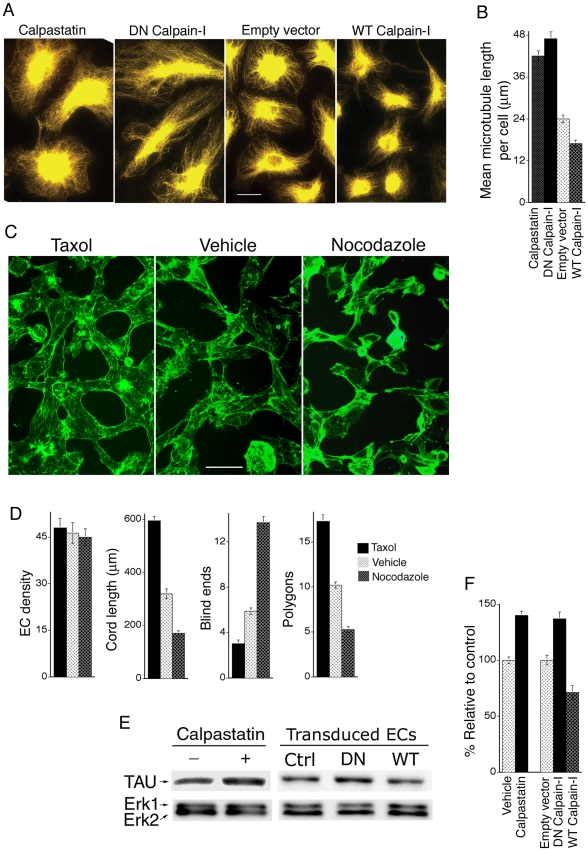
DN calpain-1 supports integration of vascular cord networks by enhancing the microtubule cytoskeleton.(A) MVECs transduced with DN calpain-I or calpastatin peptide (200 nM) exhibited a robust microtubule cytoskeleton relative to Empty Vector controls. In contrast, cells transduced with WT calpain-I exhibited a markedly diminished microtubule cytoskeleton. Microtubules were stained with α-tubulin antibody; bar  = 25 µm. (B) Quantification of mean microtubule lengths (n>20 cells; p<0.001 for DN calpain-I vs. empty vector; p<0.05 for WT calpain-I vs. empty vector; p<0.001 for calpastatin peptide vs. vehicle control). (C) Equal numbers of MVECs were stimulated with collagen-I to undergo capillary morphogenesis (as in Figure 2). Treatment with the microtubule-stabilizing agent taxol (15 µM) during the final hour of cord formation, i.e. three hours after the initiation of capillary morphogenesis (see Methods), improved cord formation and reduced blind ends whereas incubation with the microtubule-destabilizing agent nocodazole (15 µM) impaired cord formation and increased blind ends (white arrows). Cords were stained for F-actin with phalloidin; bar  = 50 µm. (D) Quantification of cord organization; n≥17; measured parameters correspond to actual areas of 0.4 mm2. Cord length: taxol vs. control p<0.001; nocodazole vs. control p<0.001. Blind ends: taxol vs. control p<0.002; nocodazole vs. control p<0.003. Polygons (closed vascular loops): taxol vs. control p<0.001; nocodazole vs. control p<0.001. (E) As determined with immunoblotting, the microtubule-stabilizing protein tau was increased in MVECs treated with calpastatin peptide or transduced with DN calpain-I, and decreased in MVECs transduced with WT calpain-I relative to empty vector (Ctrl). Total Erk1/Erk2 served as loading controls (see Methods). (F) Quantification of tau protein from blots stained with anti-tau antibody; n≥5. Calpastatin peptide vs. control: p<0.03. DN calpain-I vs. empty vector control: p<0.03. WT calpain-I vs. empty vector control: p<0.05.